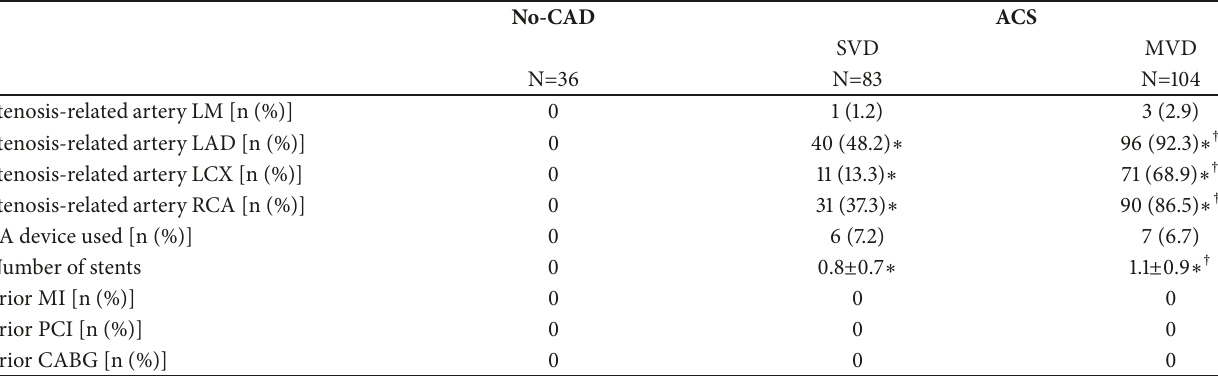
Table 3: Angiographic and procedural